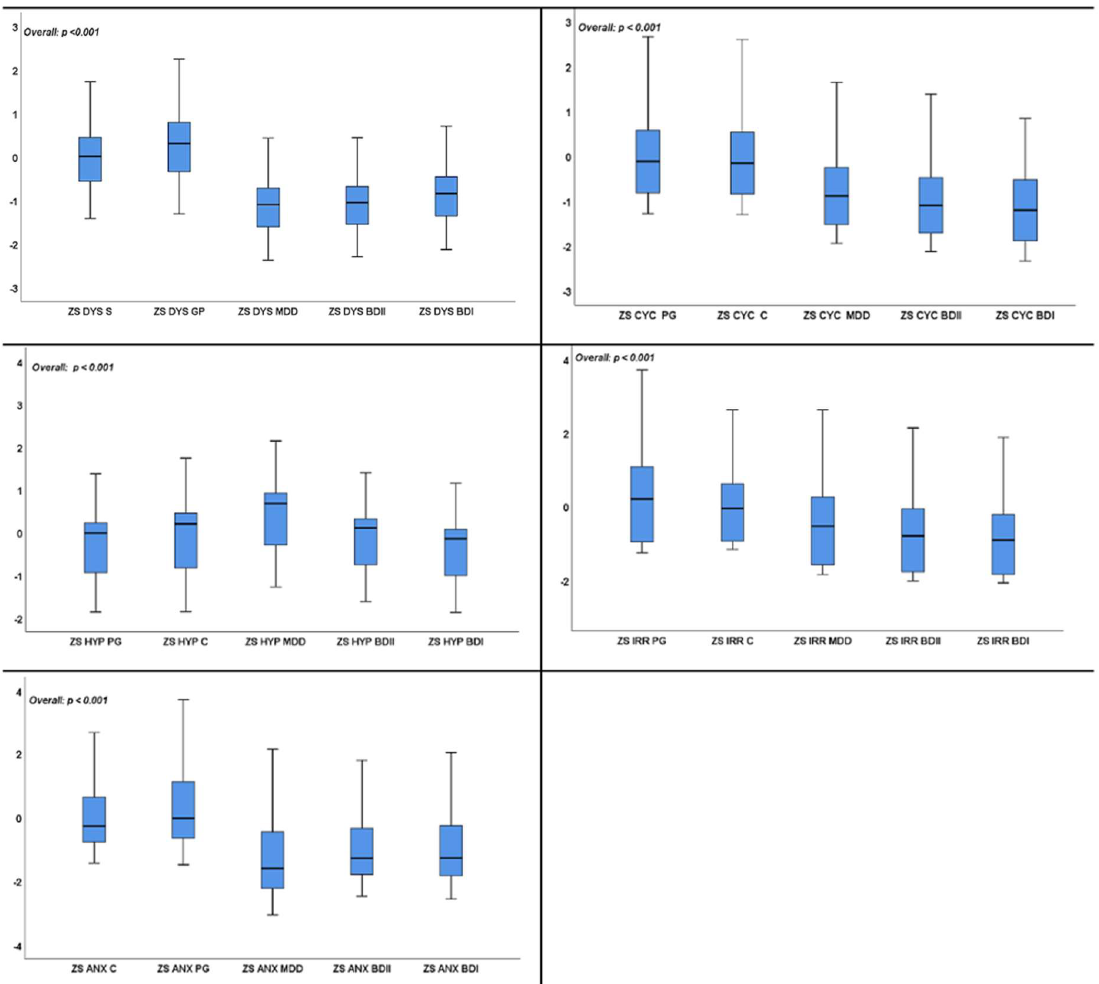
Figure 4. Multiple–Z–score comparative analysis. ZS: zeta score; HYP: hyperthymic; DYS: dysthymic; ANX: anxious; CYC: cyclothymic; IRR: irritable; GP: general population; S: sample; MDD: major depressive disorder; BDI: bipolar disorder type I; BDII: bipolar disorder type II.